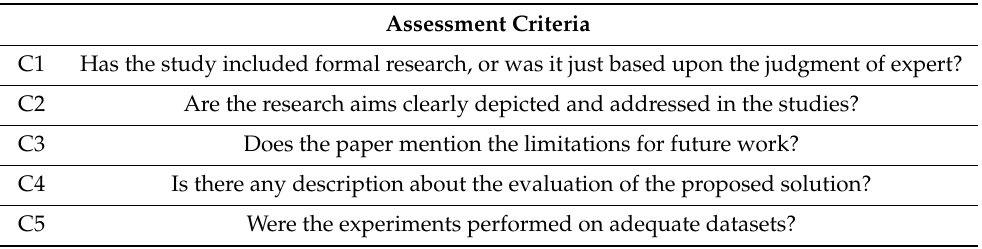
Table 9. Assessment criteria for primary